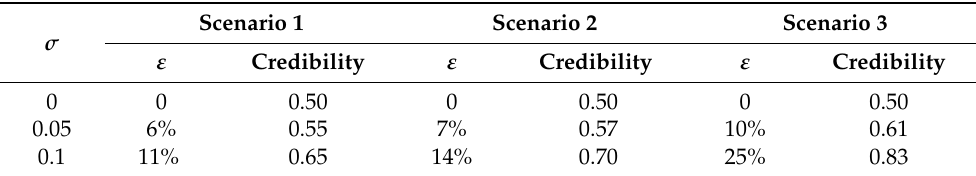
Table 5. The changes of robustness coefficient and credibility with risk aversion factors in differ- ent